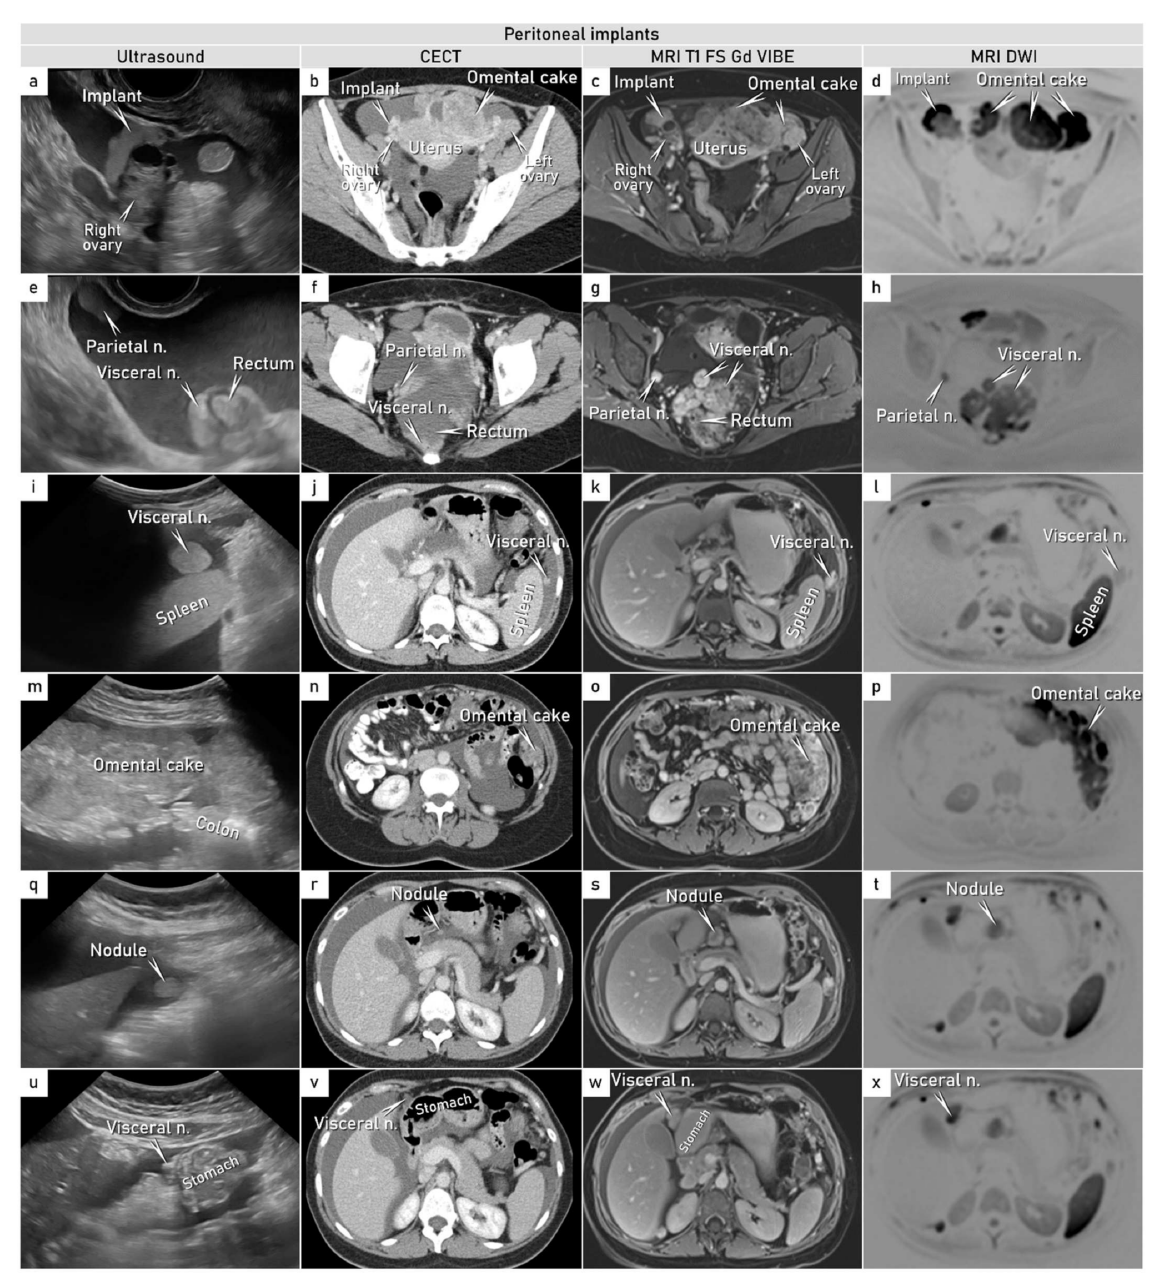
Figure 2. Peritoneal involvement (pelvis and abdomen). Ultrasound, contrast-enhanced computed tomography, and magnetic resonance with diffusion-weighted images demonstrating peritoneal metastases in transverse plane (unless stated otherwise): ( a – d ) Peritoneal visceral implant on the right non-infiltrated ovary. ( e – h ) Parietal isolated nodule on the right pelvic side wall and diffuse visceral peritoneal involvement on rectosigmoid. ( i – l ) Visceral focal nodule on the splenic surface. ( m – p ) Diffuse omental infiltration (omental cake). ( q – x ) Visceral nodules in the omental bursa and on the stomach (in sagittal plane on ultrasound). Abbreviations: n., nodule(s); MRI T1 FS Gd VIBE, T1-weighted magnetic resonance imaging after intravenous gadolinium; VIBE, volumetric interpo- lated breath-hold examination; CECT, contrast-enhanced computed tomography; DWI, diffusion weighted imaging. Supplementary Video